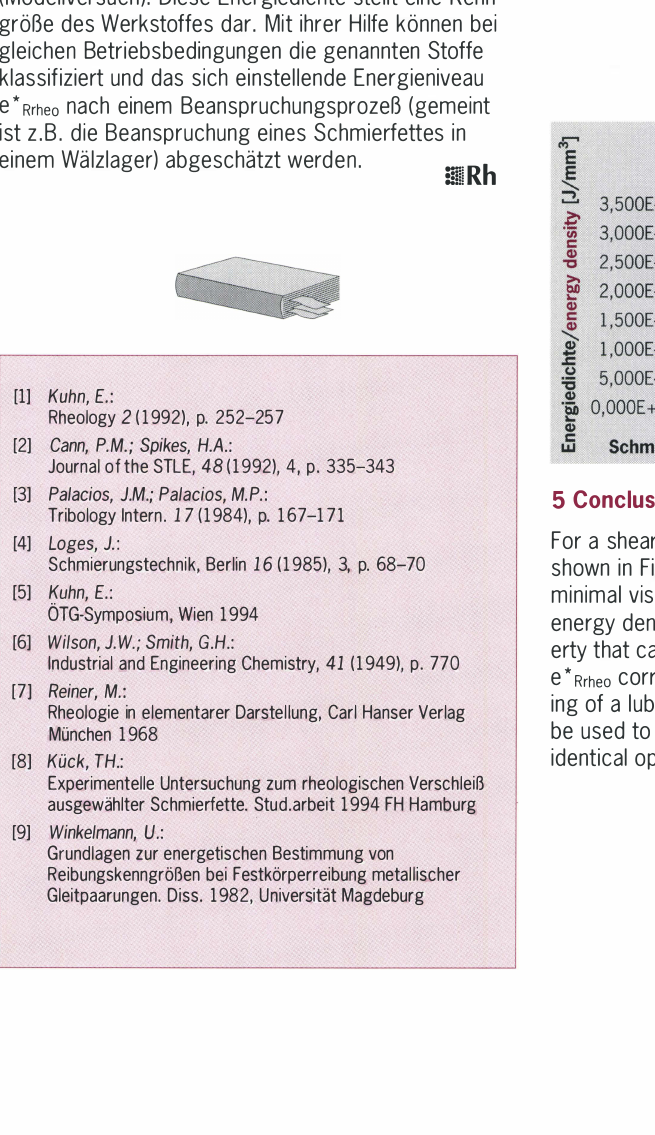
Abb. 3: Restenenergiedichte fur ein 000-Schmierfett und Vergleich mit der Bruch­